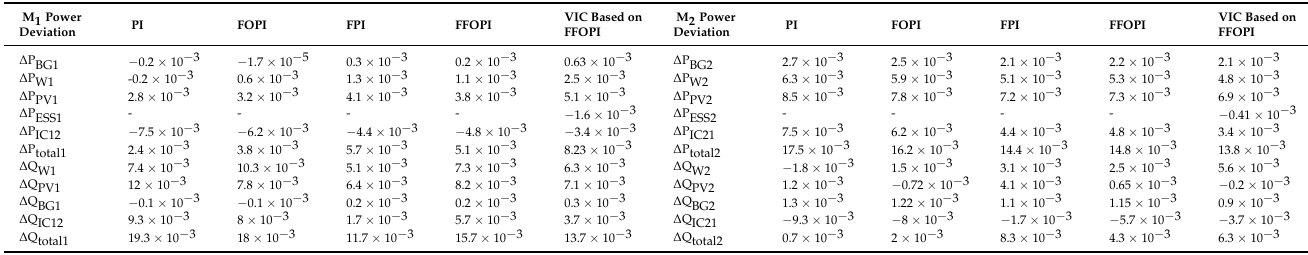
Table 13 show how the power-sharing of each generation unit in M 1 and M 2 at each controller compensate for the power imbalance during this disturbance through a multi- objective function to minimize the total power loss. The investigation of Figures 16 and 17 can be justified in Table 13. Due to the increase in solar radiation disturbance, the new value of the change in the active power of the SPVS for both microgrids M 1 and M 2 equals (0.01 * P PV ) added to the change in the active power of the SPVS at step load change only without solar radiation disturbance. Table 13. Power flow in pu of microgrid system M 1 and M 2 for each controller at solar radiation